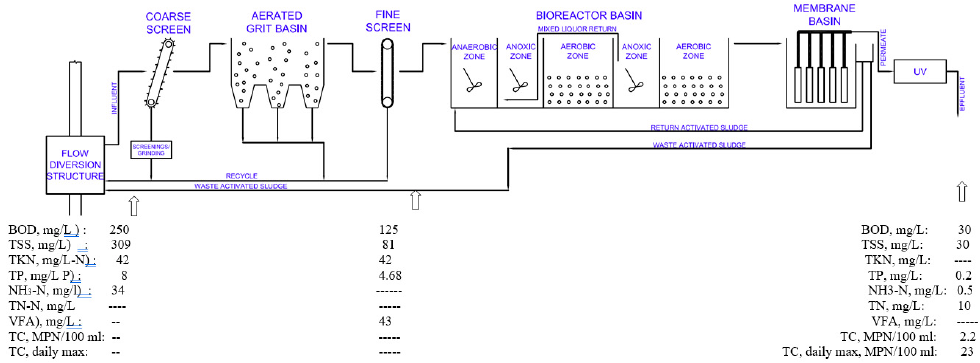
Figure 1. Process flow diagram of the example water reuse plant with influent and effluent characteristics.